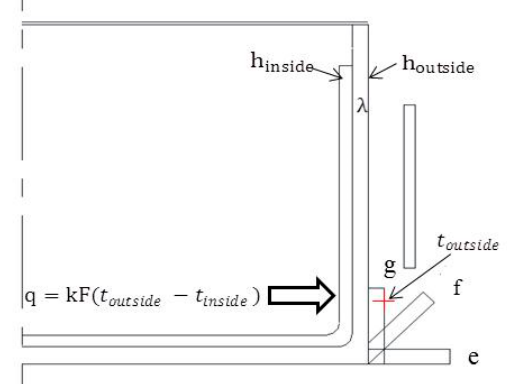
Figure9. Positionsoftheblockandheatfluxforthefurnaceusingdi ff erentblockpositions: e = horizontal Figure 9. Positions of the block and heat flux for the furnace using different block positions: e = block, f = a 45 ◦ -angle-inclined block, and g = a vertical horizontal block, f = a 45°-angle-inclined block, and g = a vertical block.